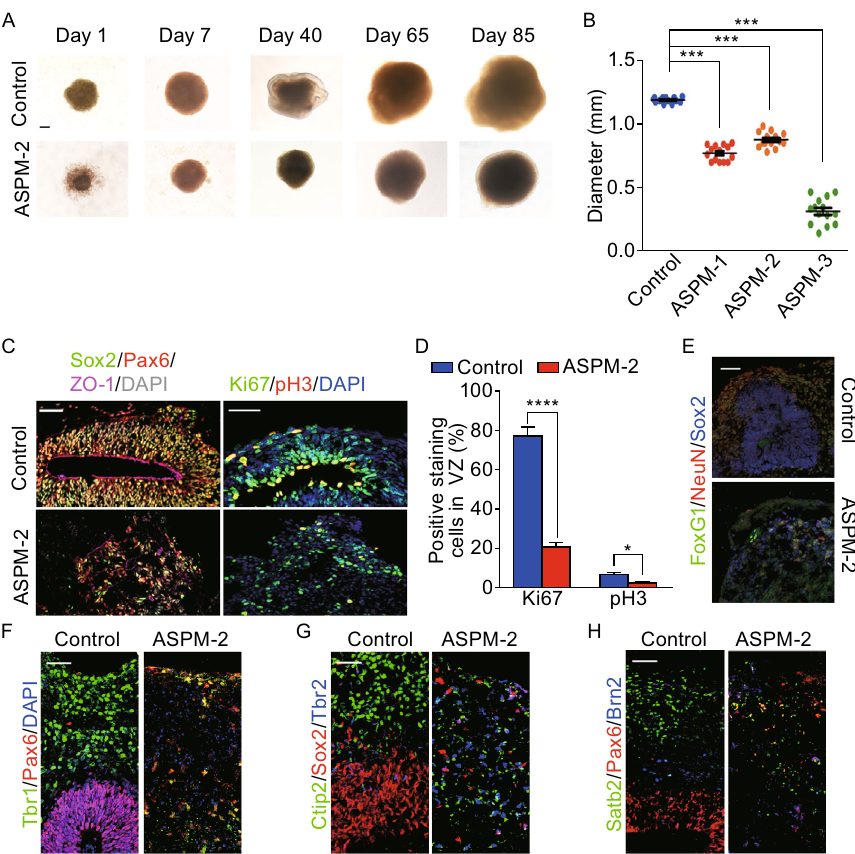
Figure 4. Human ASPM mutant organoids show disrupted cerebral development. (A) Representative BF images of control and ASPM-2 organoids at different stages. (B) The diameter of organoids generated from each hiPSC lines. (C) Immunostaining of NE markers in control and ASPM-2 organoids. (D) The percentage of Ki67 + and pH3 + cells in VZ of the developing organoids. n = 3, 3 slices for control and ASPM-2 group. (E) Immunostaining for progenitor markers of control and ASPM-2 organoids on day 65. (F) Immunostaining of telencephalic, neuronal and progenitor marker of control and ASPM-2 organoids on day 65. (G – I) Immunostaining results for progenitor and pyramidal markers of control and ASPM-2 organoids on day 65. All data are presented as means ± s.e.m. * P < 0.05; *** P < 0.001; **** P < 0.0001. Scale bar: 200 μ m in (A), 50 μ m in (C, E